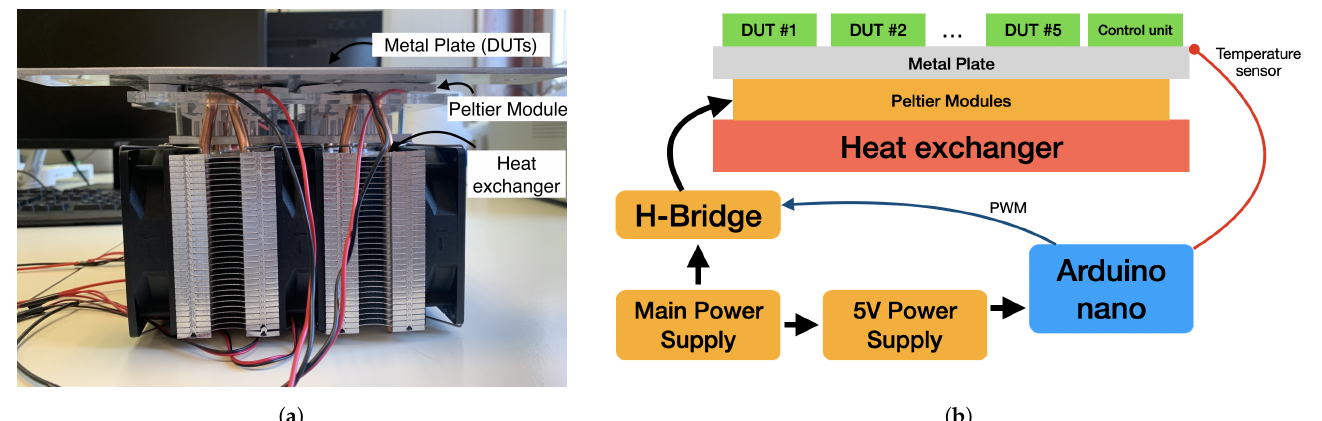
Figure 3. Testbench used to induce the temperature variations during the tests. ( a ) Peltier modules with the metal plate and the heat exchanger. ( b ) Working